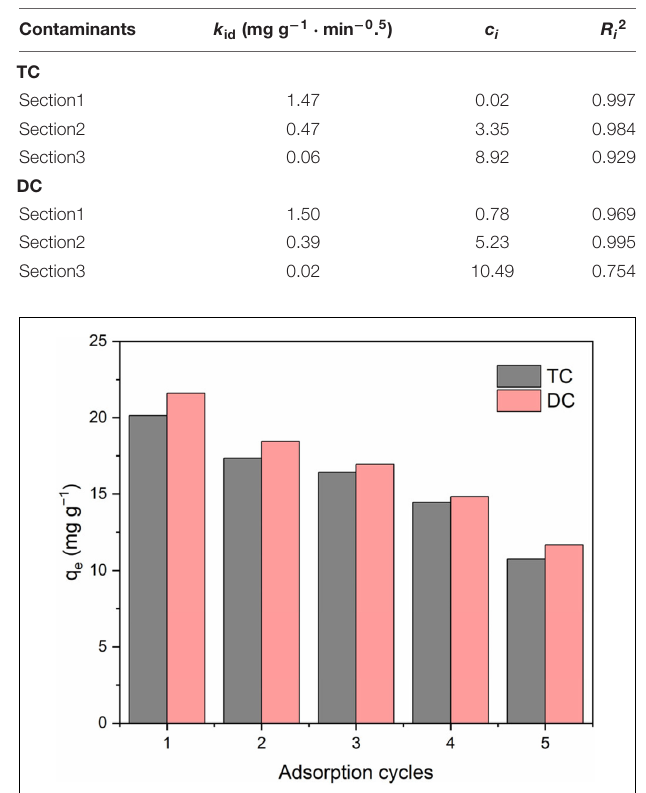
FIGURE 11 | The adsorption performance of TC and DC by BC/MnO 2 after different adsorption cycles.